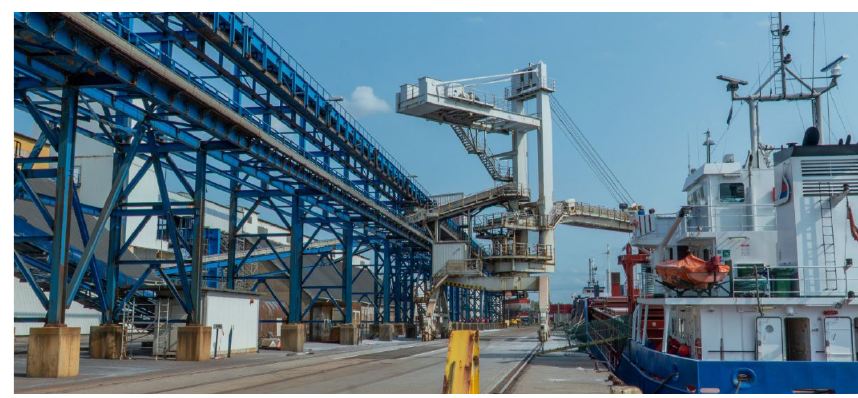
Fig. 4. Bulk ship loader [Compiled by the authors].